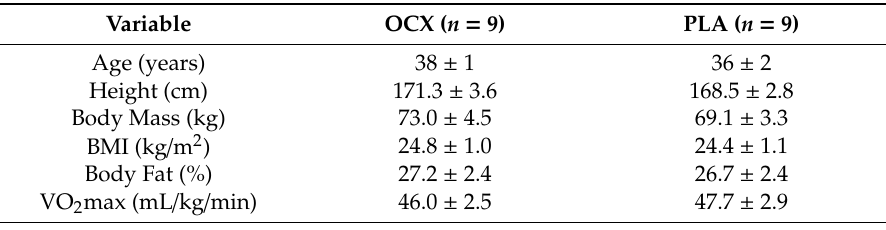
Table 1. Subject